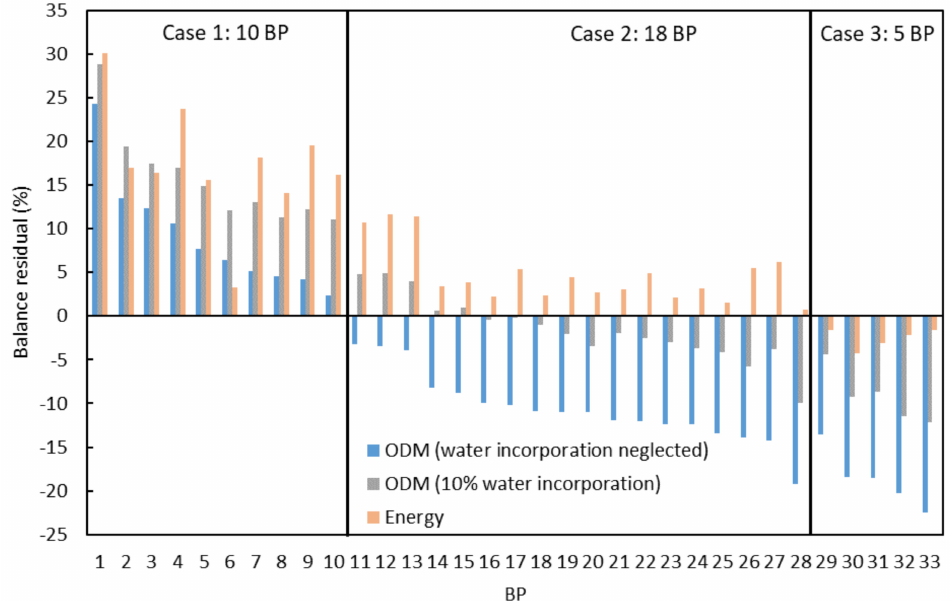
Figure 2. Balance residual of the organic dry matter content (ODM) material balance without and with considering a 10% water incorporation and the energy balance for 33 biogas plants (BP). A positive value means missing mass/energy in the output. BPs are grouped in three categories (Case 1: positive ODM and energy balance, Case 2: negative ODM balance and positive energy balance and Case 3: negative ODM and energy balance), sorted by the three cases at first and the ODM balance residual without consideration of water incorporation as